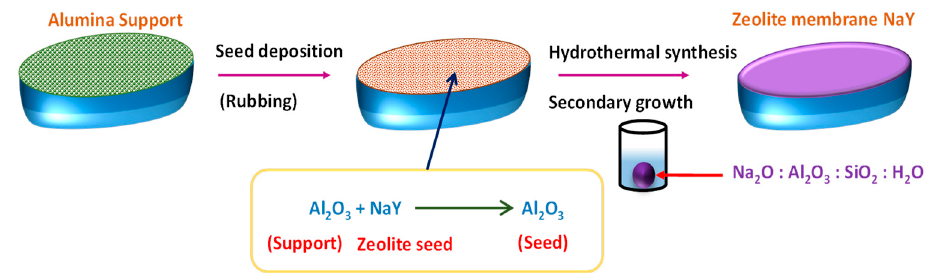
Figure 25. One-step method for the preparation of the zeolite membrane.